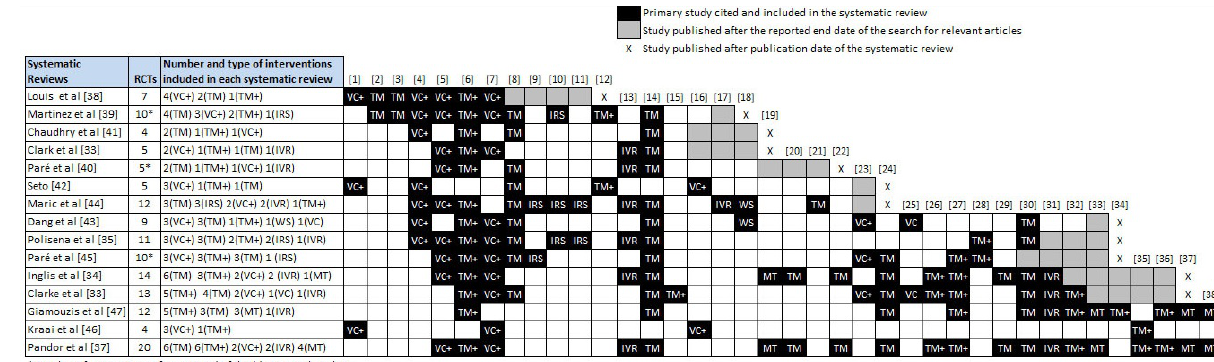
Figure 2. Citation matrix of previously published RCTs included in the 15 systematic reviews (all references are available in Multimedia Appendix